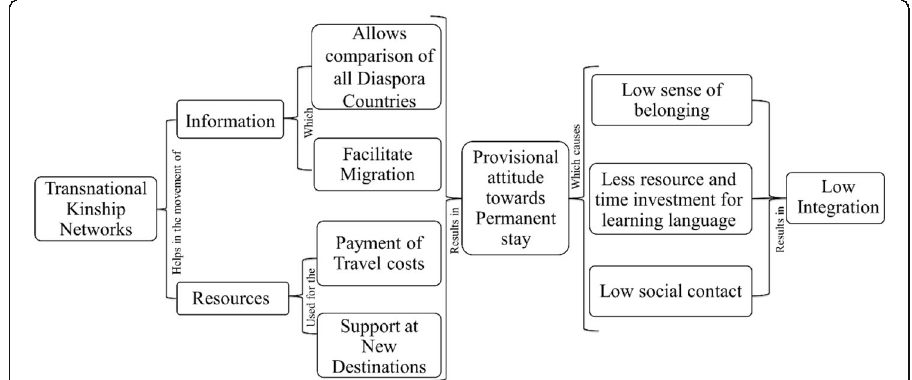
Fig. 3 The effects of transnational links of Indian immigrants in Spain and Italy on their level of integration into the host societies. Source: compiled by the first author on the basis of in-depth interviews during 2016 –